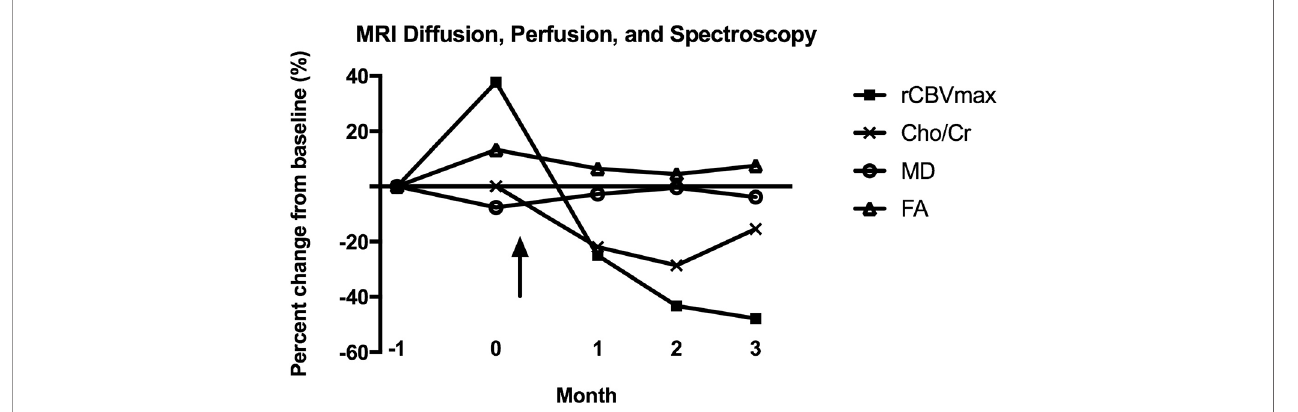
FIGURE 4 | Percent change from baseline for MRI diffusion (MD, FA), perfusion (rCBVmax), and spectroscopy (Cho/Cr) parameters after CAR T-EGFRvIII infusion. No MR spectroscopy was performed at month -1, so the baseline for Cho/Cr is month 0. The arrow indicates the date of CAR T-EGFRvIII infusion. MD, mean diffusivity; FA, fractional anisotropy; rCBVmax, maximum relative cerebral blood volume; Cho/Cr,